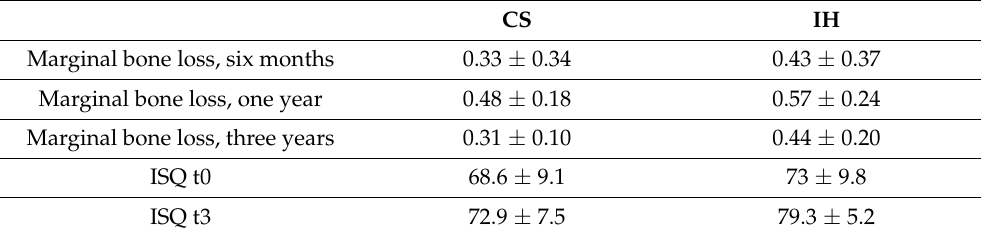
Table 2. Clinical Outcomes ISQ (implant-stability quotient) MBL (mean bone loss).